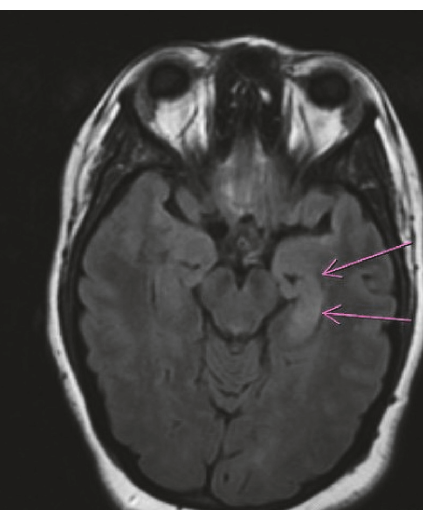
Figure 1: Asymmetric increased flair signal over the left hippocam-